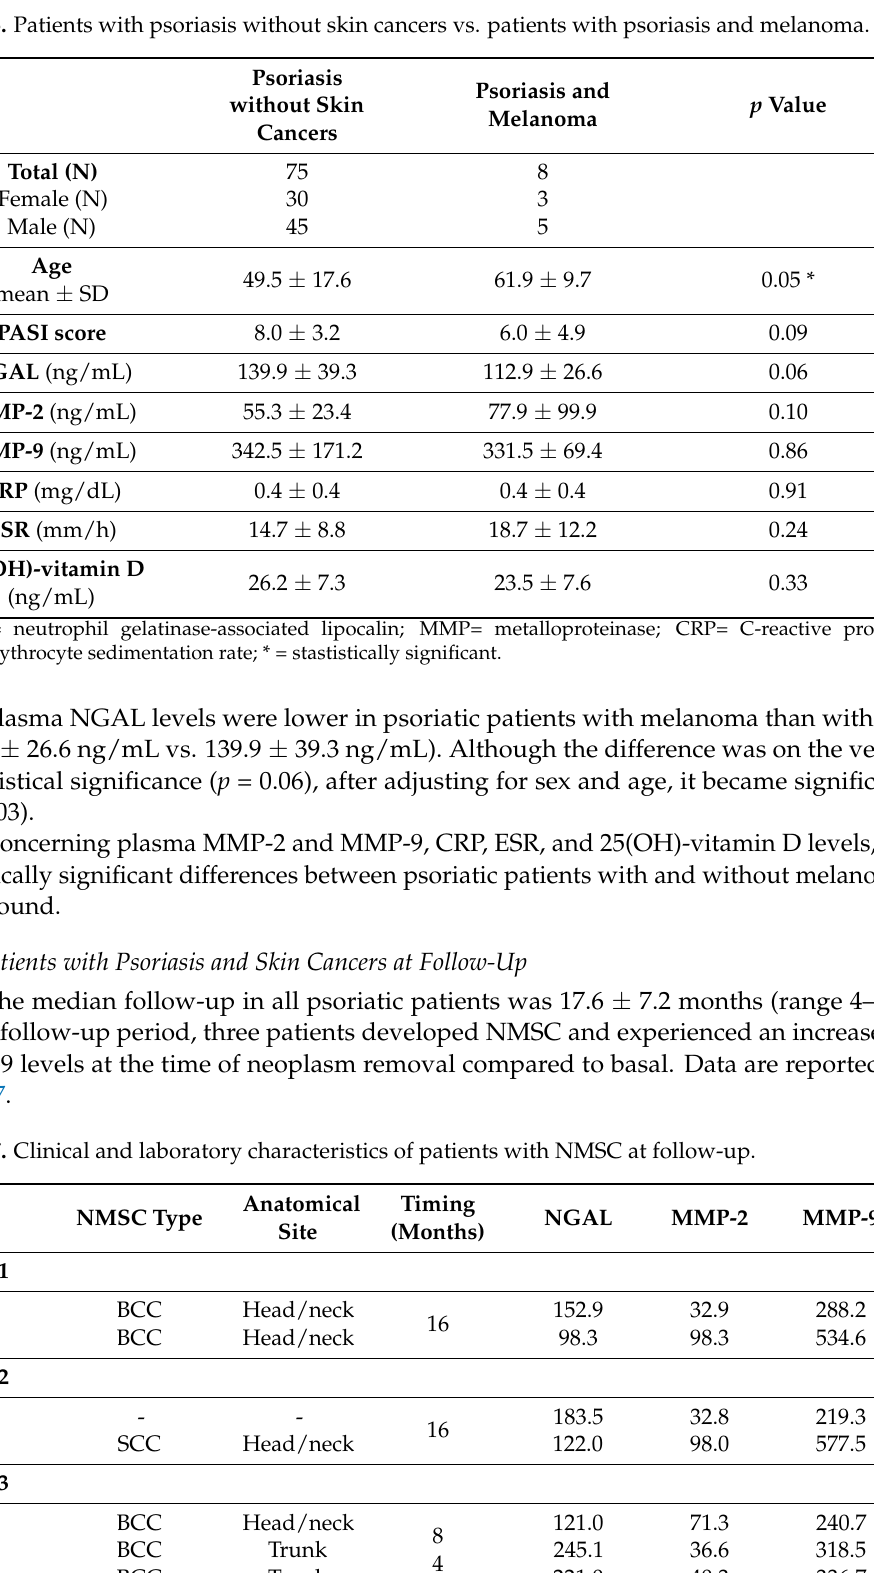
Table 6. Patients with psoriasis without skin cancers vs. patients with psoriasis and melanoma.